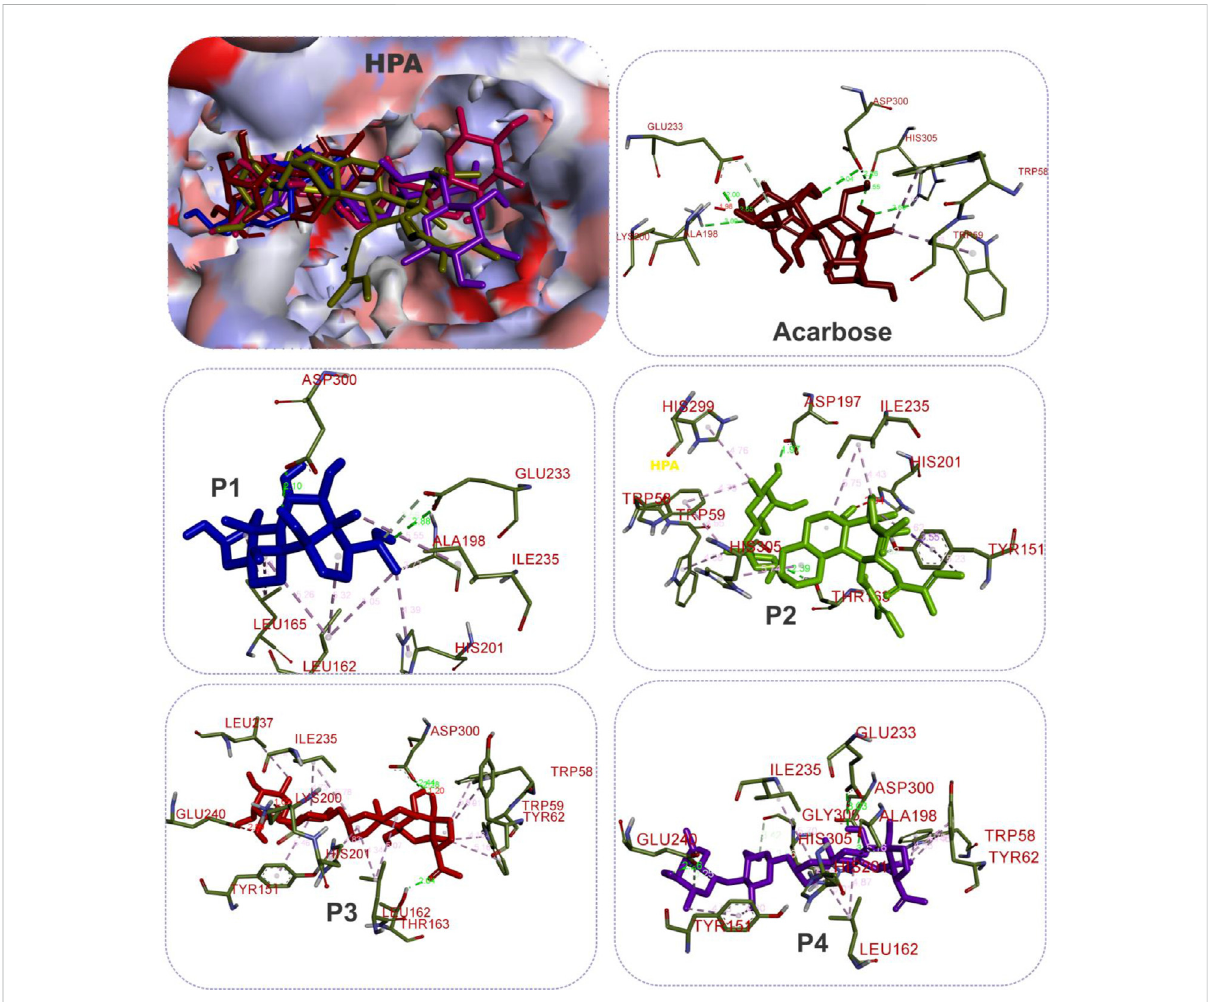
FIGURE 6 The 3D depiction of the interactions of acarbose and the isolated steroidal pregnanes with amino acid residues in the active site of human pancreatic alpha-amylase (HPA). Ligands are depicted in stick representations in colors red: acarbose (reference inhibitor); blue: P1; green: P2; pink: P3; purple: P4. Interaction types (dotted lines) and their bond lengths are depicted in green (H-bonds); light purple: hydrophobic interactions (pi- alkyl,alkyl,andpi-stacking);purple:pi-piT-shaped interactions;yellow: pi-sulfurinteractionsandpi-stackinginteractions.Amino acidresidues are in a three-letter